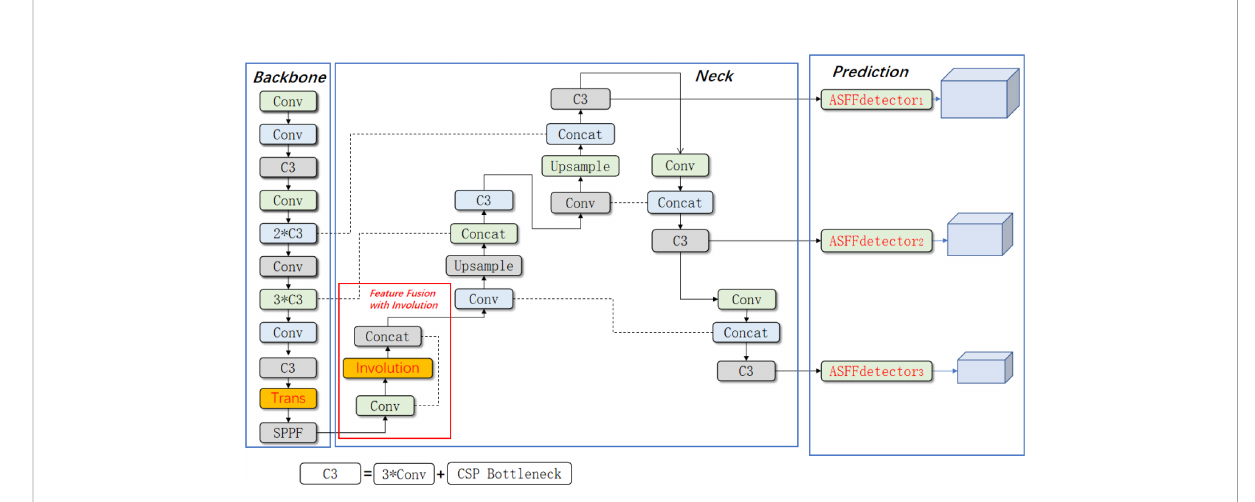
FIGURE 1 Architecture of the proposed TIA-YOLOv5 network. (* means